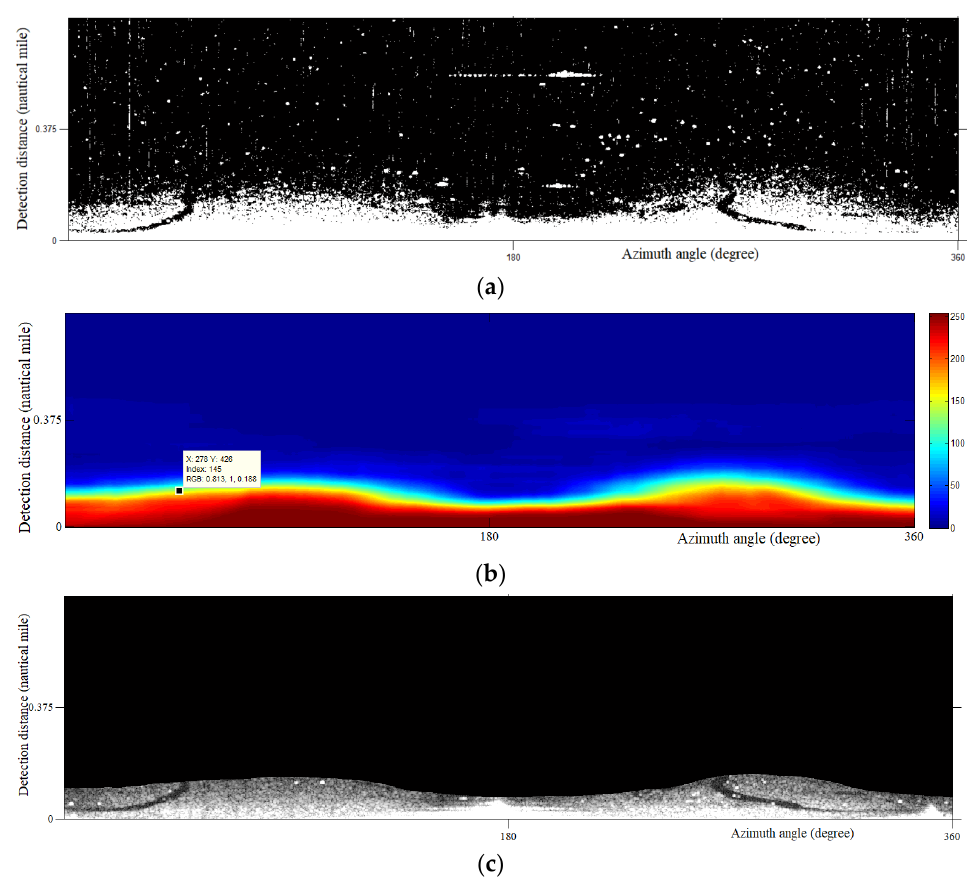
Figure 16. The threshold in the gray distribution matrix was manually selected to determine the effective monitoring range of ocean wave. ( a ) SVM classification results of ocean wave; ( b ) Segmentation threshold was manually selected; ( c ) The ocean wave monitoring range was divided according to the threshold ‘145’.